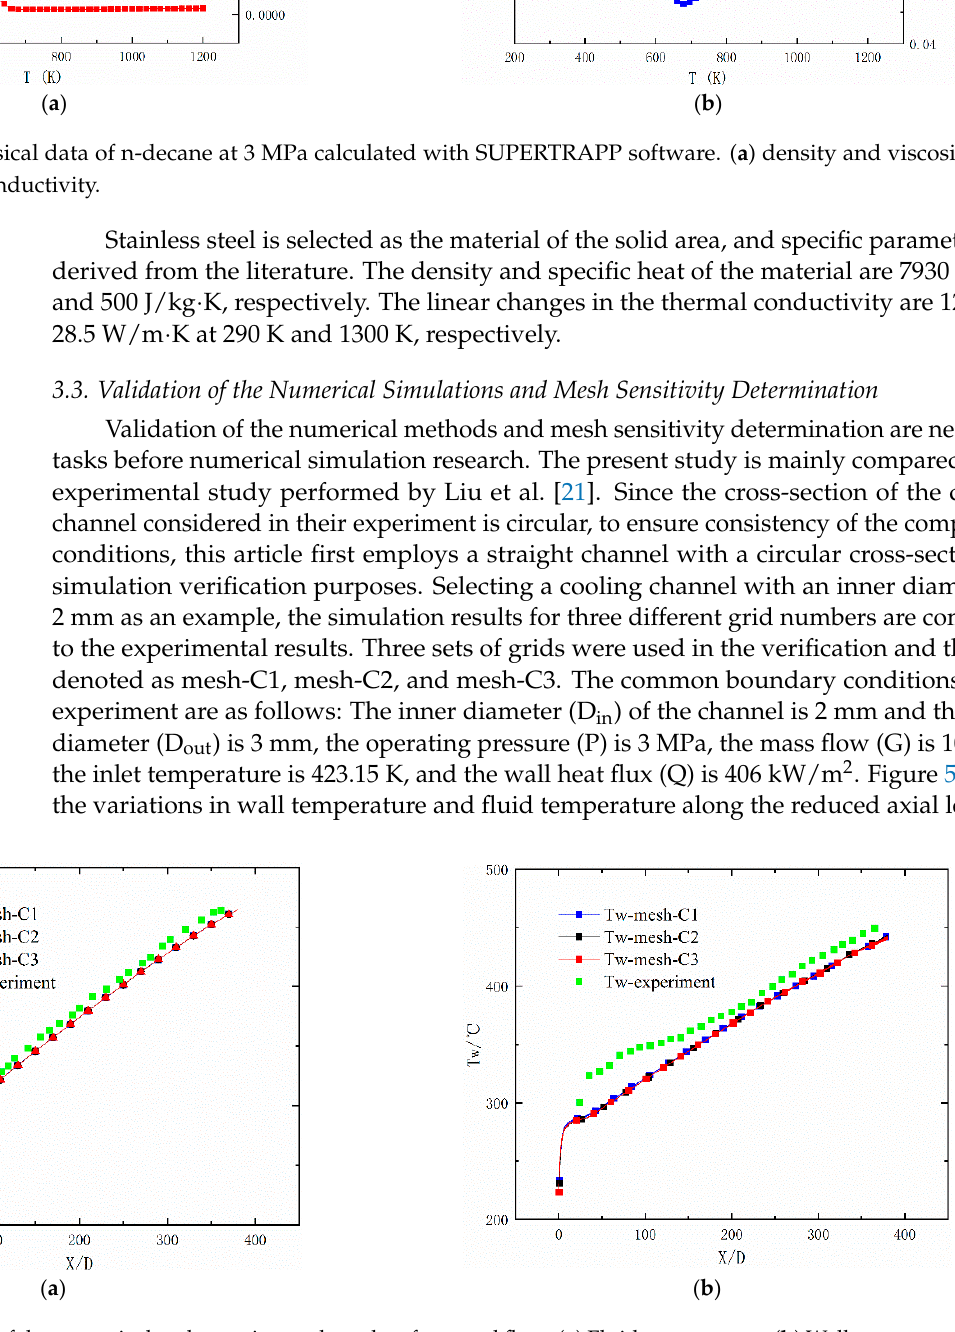
Figure 5. Comparison of the numerical and experimental results of upward flow. ( a ) Fluid temperature; ( b ) Wall temper- ature.